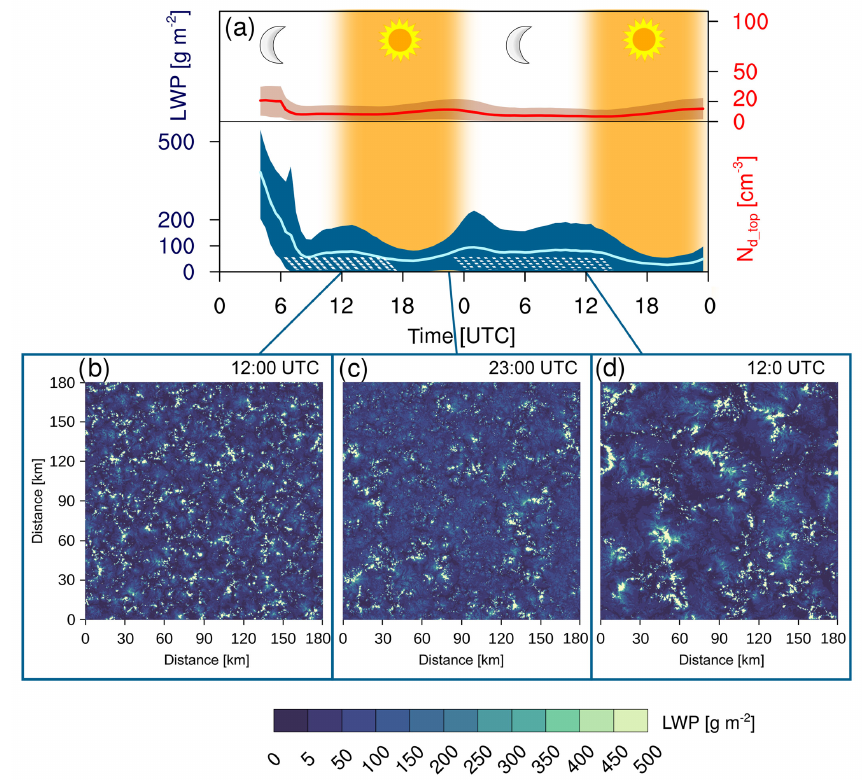
Figure 1. (a) Time series of domain-mean liquid water path, LWP (green), and cloud-top droplet number concentration, N d_top (red), for the ctrl simulation. Shading (blue for LWP, black for N d_top ) denotes interdecile percentile range. Snapshots of LWP are shown in (b) after initial organised structures developed, (c) after the solar maximum and (d) for the second day organised state.